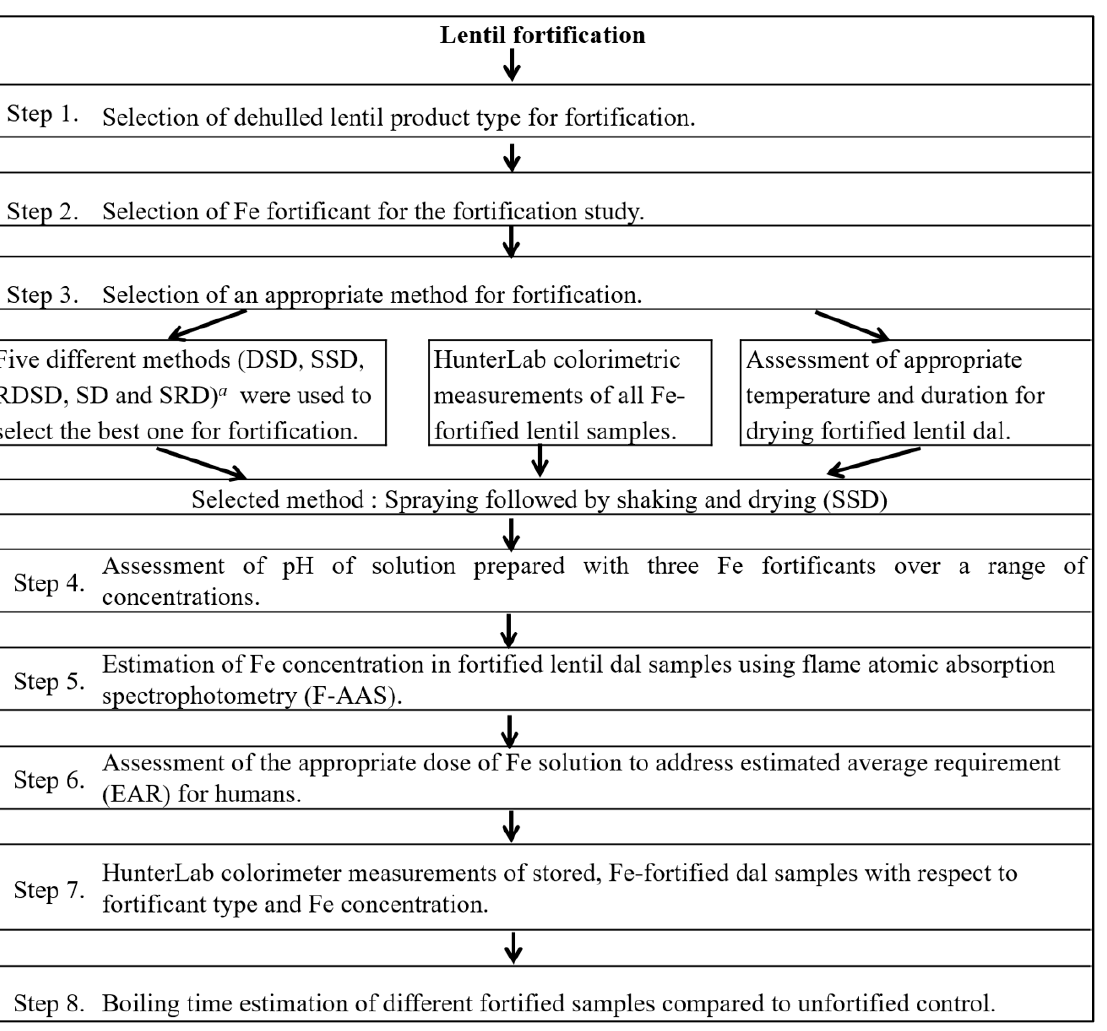
Figure 1. Flow chart for development of a lentil fortification protocol. a Oven dried, soaked and oven dried (DSD); sprayed followed by shaking and drying (SSD); rinsed, oven dried, soaked, and oven dried (RDSD); directly soaked in Fe solution (SD) and rinsed, soaked, and oven dried (SRD).